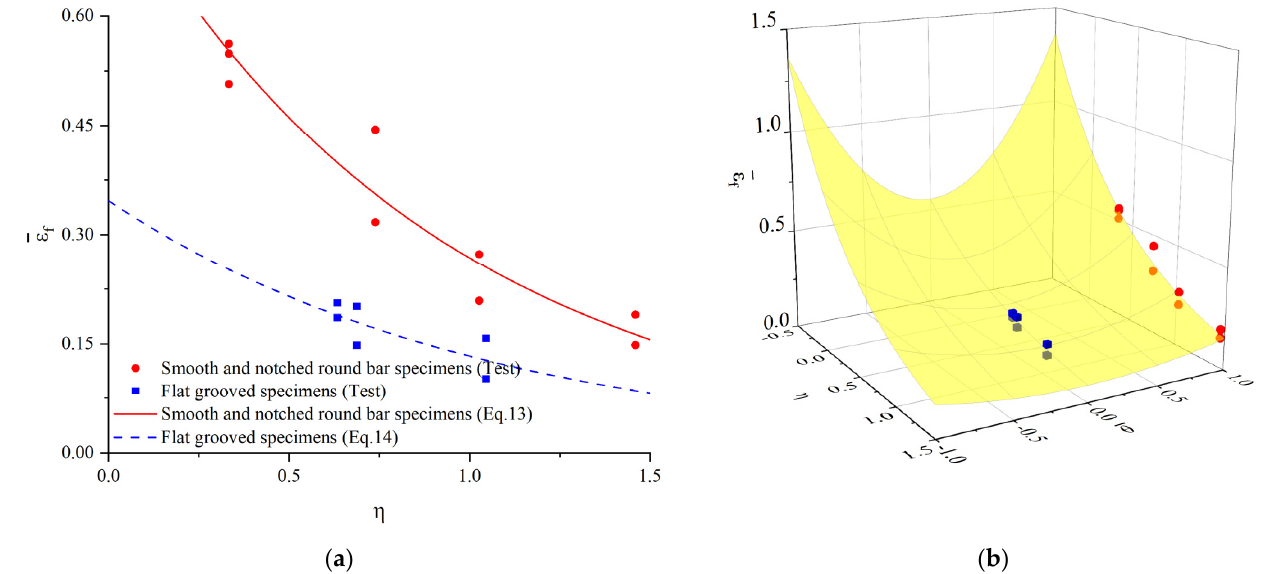
Figure 7. Fracture locus of ML15: ( a ) Rice–Tracey model, ( b ) Bai–Wierzbicki model.